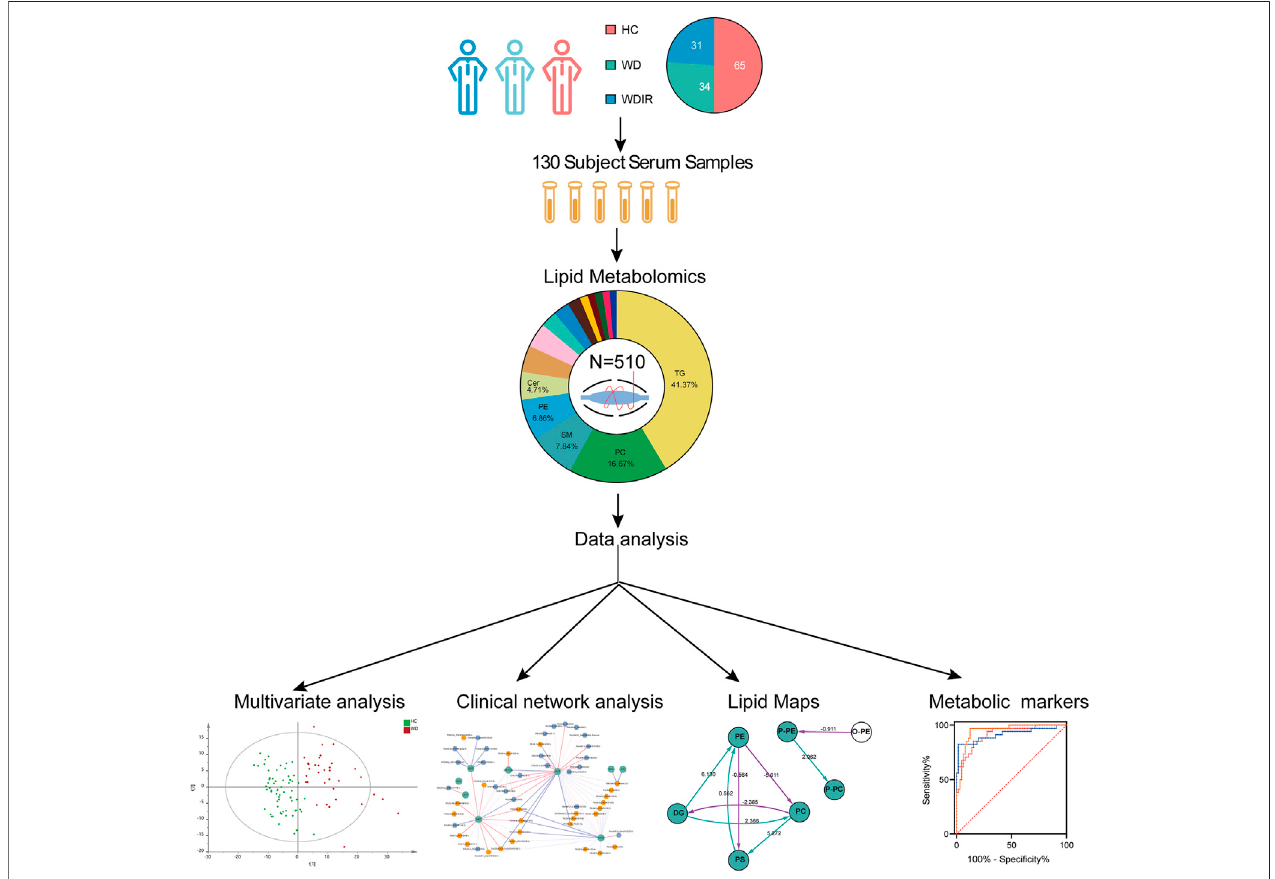
FIGURE1| Work fl owofWDserum analysis. This fi gure depicts thedesign and stepsofthisstudy,beginningwithsamplecollection for thethree cohorts, followed by untargeted lipidomic analysis, and then the various data analyses employed, including PCA, OPLS-DA, univariate T-test and ANOVA.